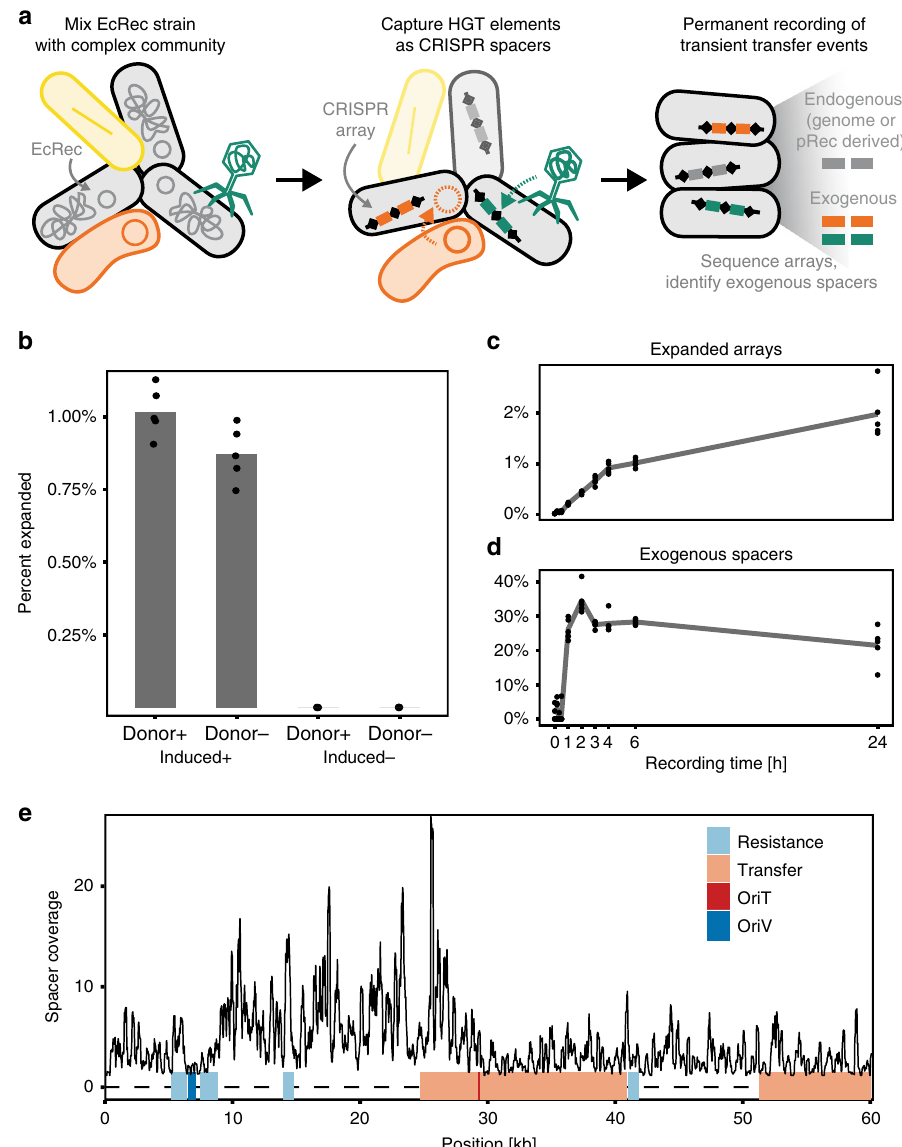
Fig. 1 Recording HGT with engineered CRISPR acquisition. a Schematic of HGT recording where the EcRec strain is mixed with donor cells and spacers are acquired from both endogenous and exogenous DNA sources. Resulting CRISPR arrays are sequenced to determine the identity and origin of spacers. b Results from recording for 6 h with or without induction and with or without FS1290/RP4 as donor strain ( n = 5 biological replicates with mean bar, no gel- extraction). c Array expansion is detected within 1 h after induction and increases rapidly for the fi rst 4 – 6 h ( n = 5 biological replicates with mean line, no gel-extraction). d Unique exogenous spacers are detected 1 h after induction constituting ~30% of all spacers ( n = 5 biological replicates with mean line, no gel-extraction). e Mapping of recorded unique spacers to the RP4 plasmid. Spacer coverage is average coverage per bp. in 200 bp. windows and based on 5 biological replicates